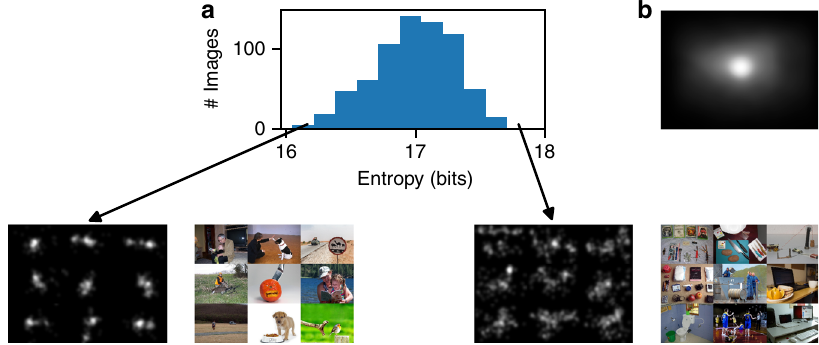
Fig. 6 Gaze entropy and center bias during free viewing on phones. a Histogram of gaze entropy across all images for the free viewing task along with examples of low vs. high entropy images. b Averaging the fi xations across all users and images reveals a center